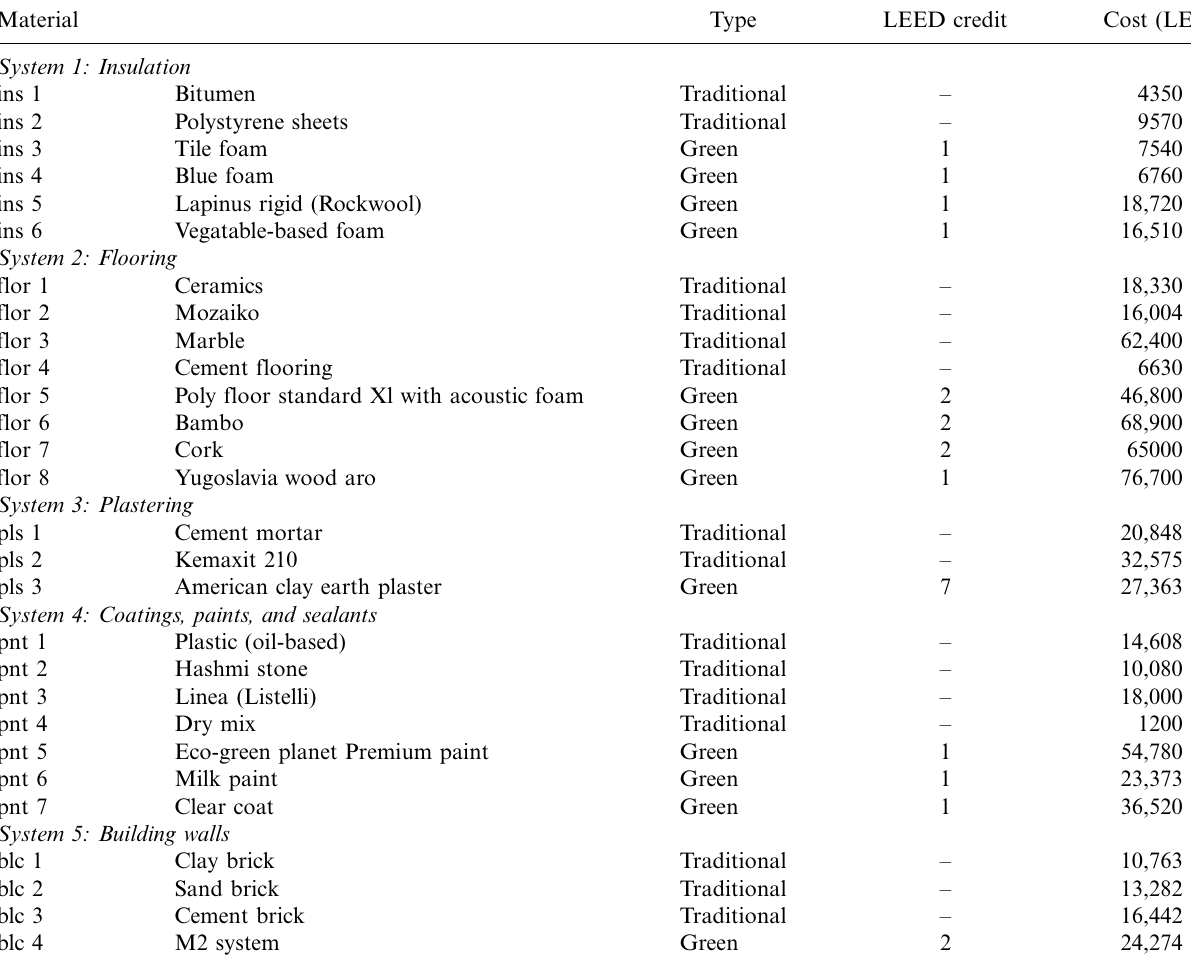
Table 2. General data of case